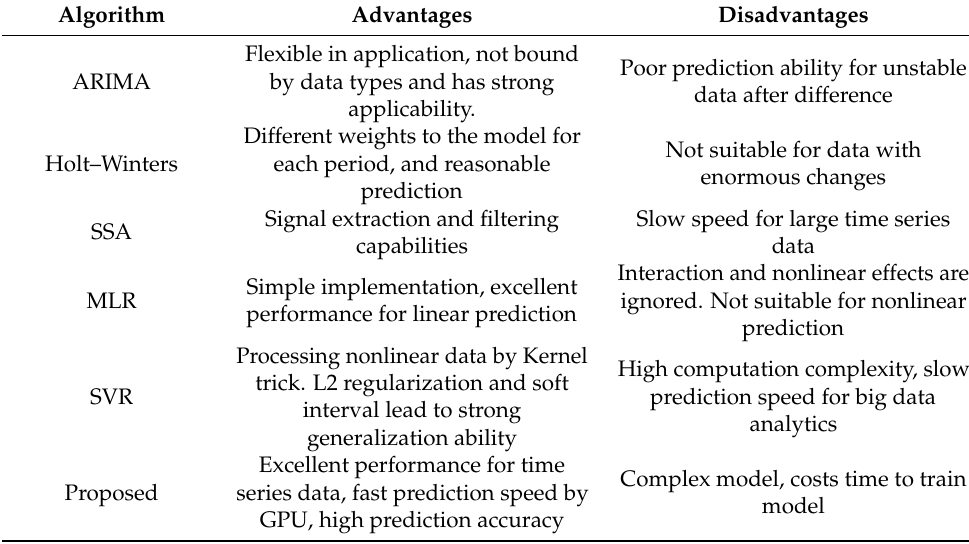
Table 2. The advantages and disadvantages of contrastive algorithms.